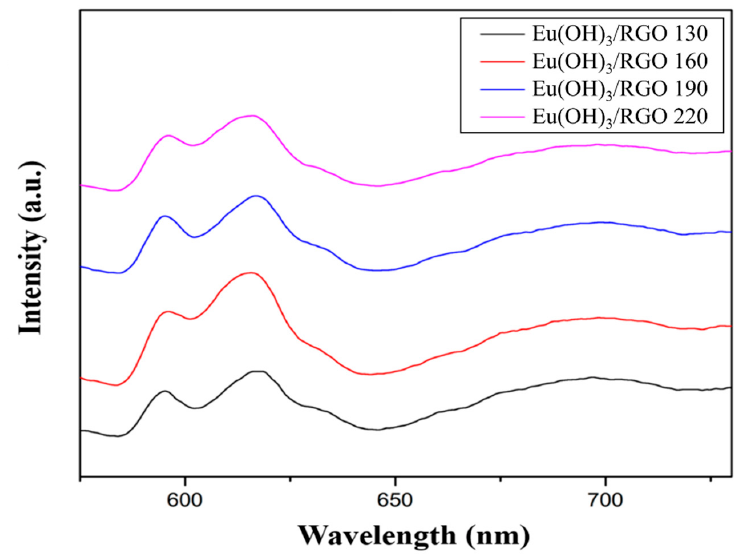
Figure 6. Photoluminescence spectra of Eu(OH) 3 /RGO. A wavelength ( λ ex ) of 395 nm was used for fluorescence excitation.